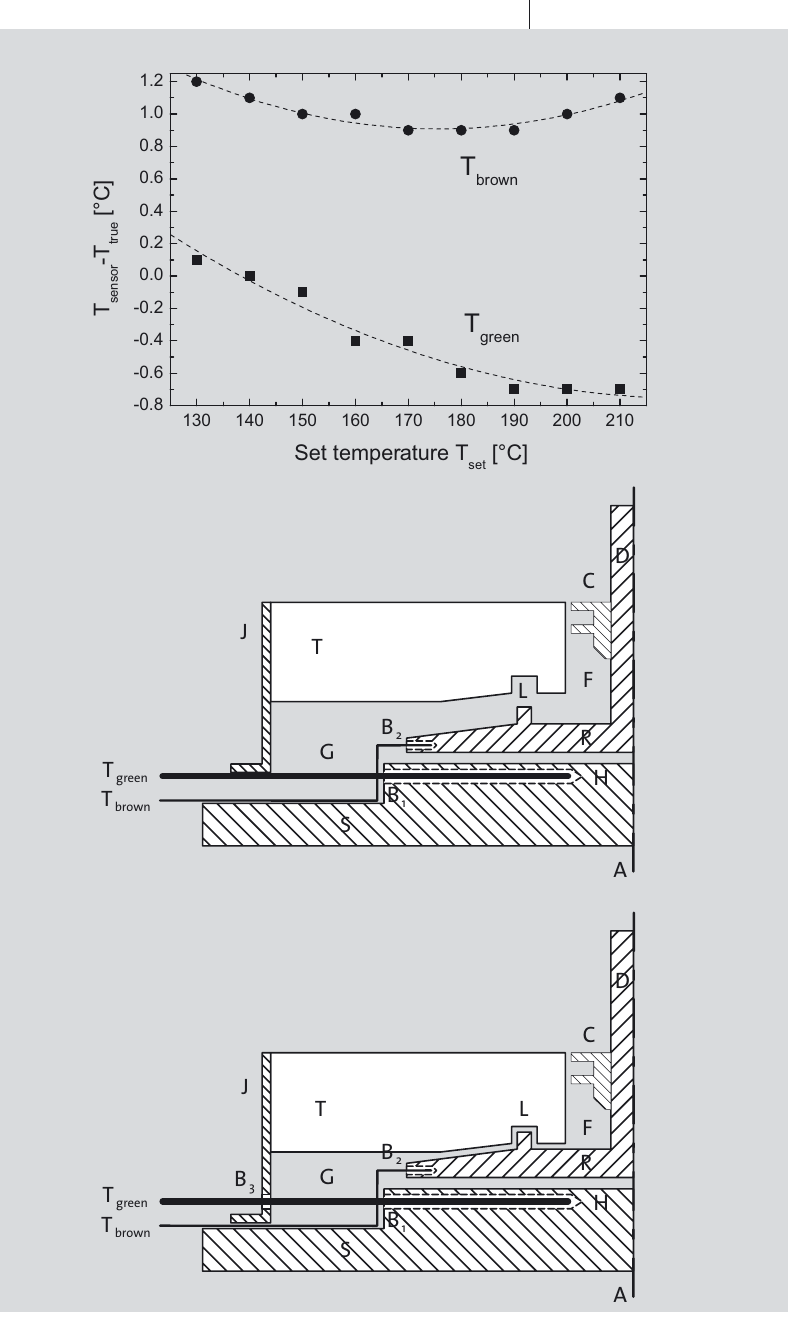
Fig. 1 (above): Calibration curves for the two thermocouples used. Details on the instruments used for temperature display and calibration are mentioned in the text. Fig. 2 (middle): Schematic cross section through rheometer with plate/plate geometry. Cali- bration set-up A. C collar to reduce draft, L labyrinth sealing, B 1 bore one, diameter 2.9 mm, B 2 bore two, diameter 0.6 mm, B 3 bore three through jacket, diameter 2 mm, J jacket of hood oven, T heating block of oven, S stationary member, R rotating member, G venting gas volume of oven, D driving shaft of rotating member, A axis of rotation, F annular funnel. Fig. 3 (below): Schematic cross section through rheometer with plate/plate geometry. Calibra- tion set-up